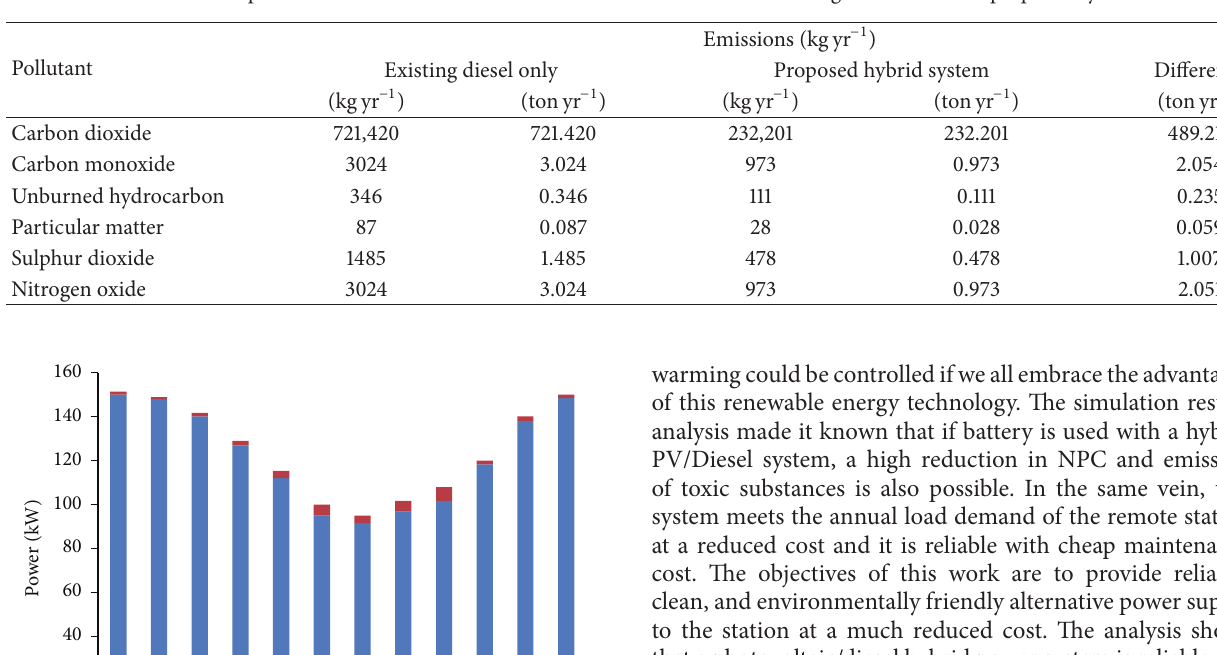
Table 10: Comparison of simulation results of emissions from standalone diesel generator set and proposed system.